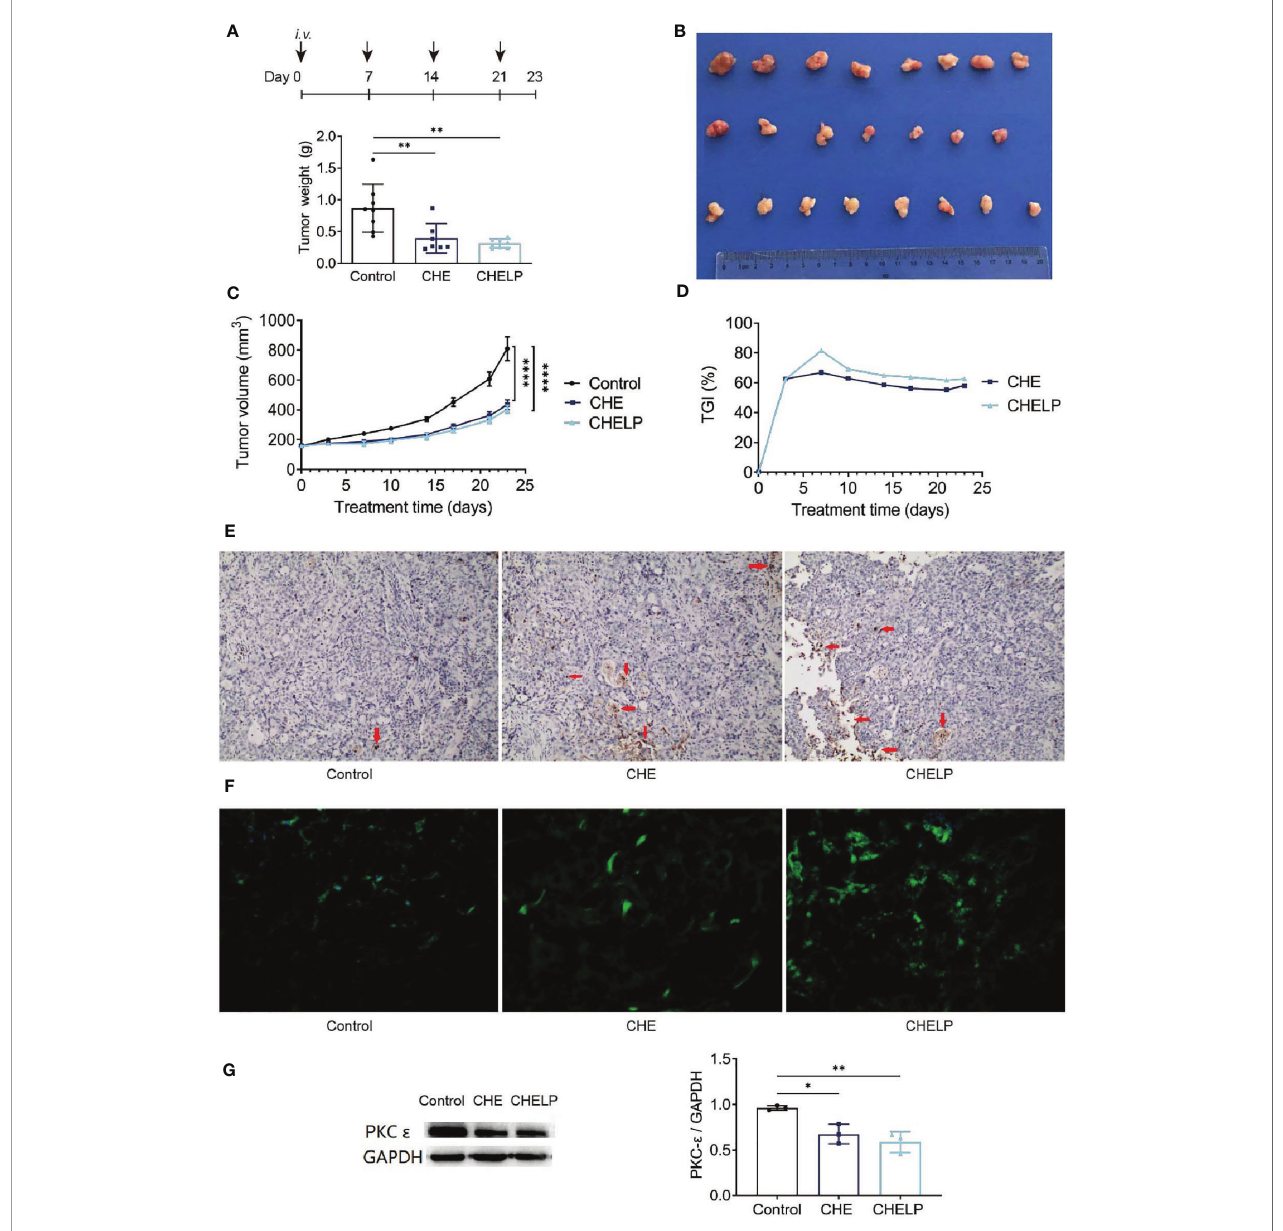
FIGURE 9 | Antitumor effect of CHE and CHELP on HCC827 tumor-bearing nude mice. (Saline group n = 8; CHE treatment group n = 7; CHELP treatment group n = 8). (A) Tumor weight; (B) the record of tumors; (C) tumor growth; (D) tumor growth inhibition; (E) apoptosis of tumors; (F) ROS generation detection in tumors; (G) the expression of PKC- ϵ in tumors (n = 3). (****p < 0.0001, **p < 0.01, *p <